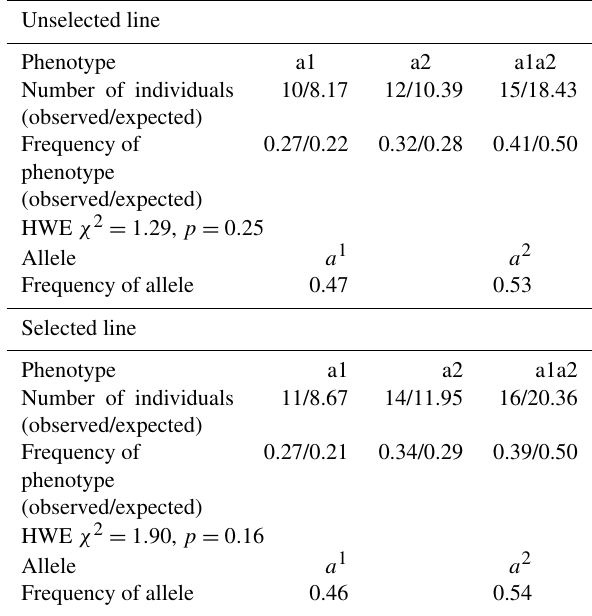
Table 3. The distribution of histone H1.a phenotypes and alleles among quail lines.